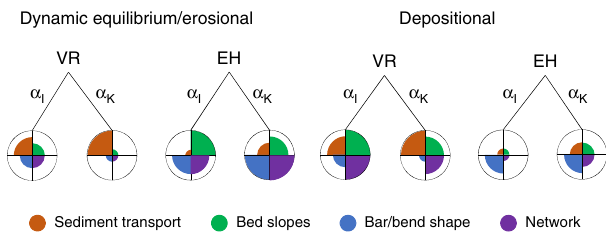
Fig. 8 Model design recommendations. Relative performance for each combination of transport predictor and slope method in models of either erosive or balanced environments where bank erosion is necessary or depositional environments. Relative performance is divided into four categories, such that the choice of predictors can be made depending on the research objective. Network characteristics include braiding index and the number of channels in, e.g., a tidal basin or